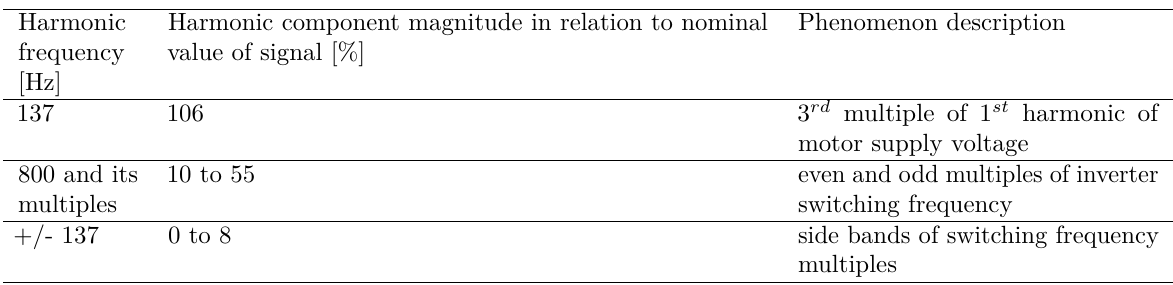
Table 1. Harmonic frequencies of electromagnetic torque – overview and description.